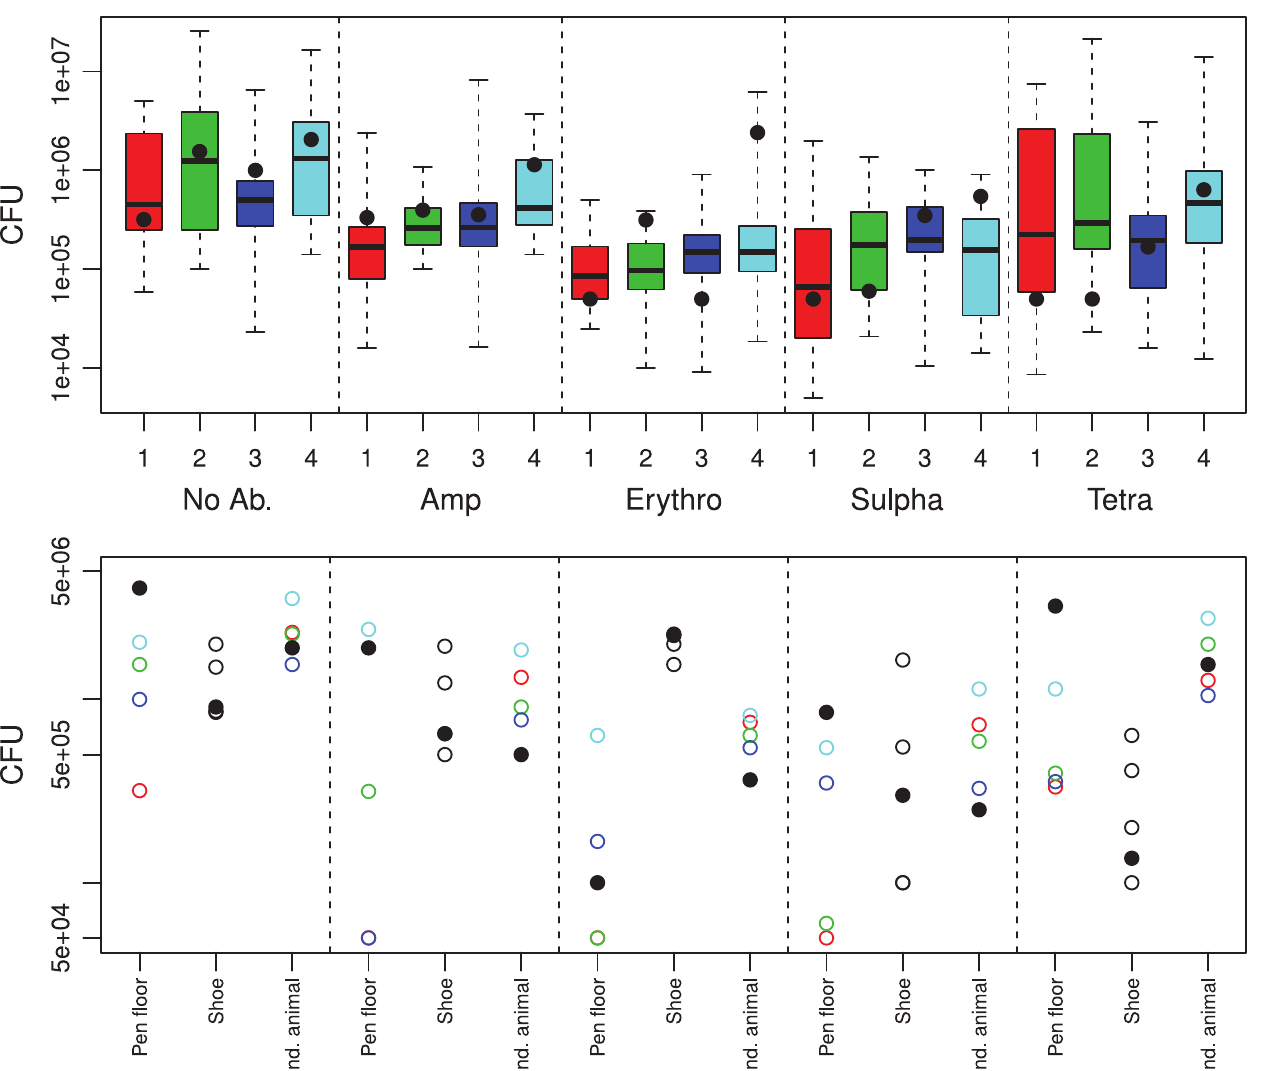
Fig 1. Sampling 1 coliform bacteria CFUs g -1 feces in individual animals within pens 1 – 4. Top: Boxplot showing the distribution of the coliform bacteria CFUs from sampling 1 in individual animals within pens 1 – 4 (pen 1, red, n = 22; pen 2, green, n = 20; pen 3, purple, n = 22; pen 4, blue, n = 20) on MacConkey plates (No Ab. = no antibiotics, Amp = ampicillin, Erythro = erythromycin, Sulpha = sulphonamide, Tetra = tetracycline). The bottom and top of the boxes are the first and third quartiles, respectively. The black band inside the box is the median and the “ dotted-whiskers ” represent the maximum (greatest CFU number values, excluding outliers) and minimum (lowest CFU value, excluding outliers). The solid circles are the individual animal pool pen samples within each pen. Bottom: The distribution of coliform bacteria CFUs from different sampling and pooling methods from sampling 1. The sampling methods are given under the bottom (Pen floor = pen floor sample; Shoe = shoe cover sample; Ind. animal = Individual animal sample). Each pen is represented by their colored circle (pen 1, red circle; pen 2, green circle; pen 3, purple circle; pen 4, blue circle), and the corresponding stable pools are solid black circles. The individual shoe cover samples are empty black circles, and the corresponding stable pool is a solid black circle.